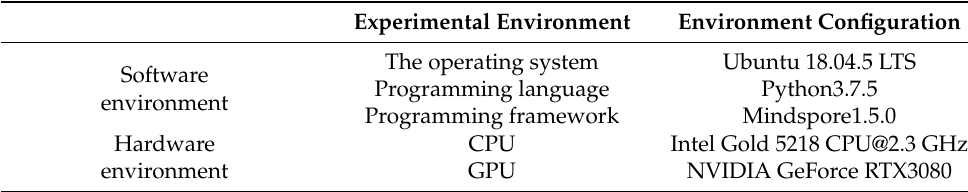
Table 7. Description of the software and hardware